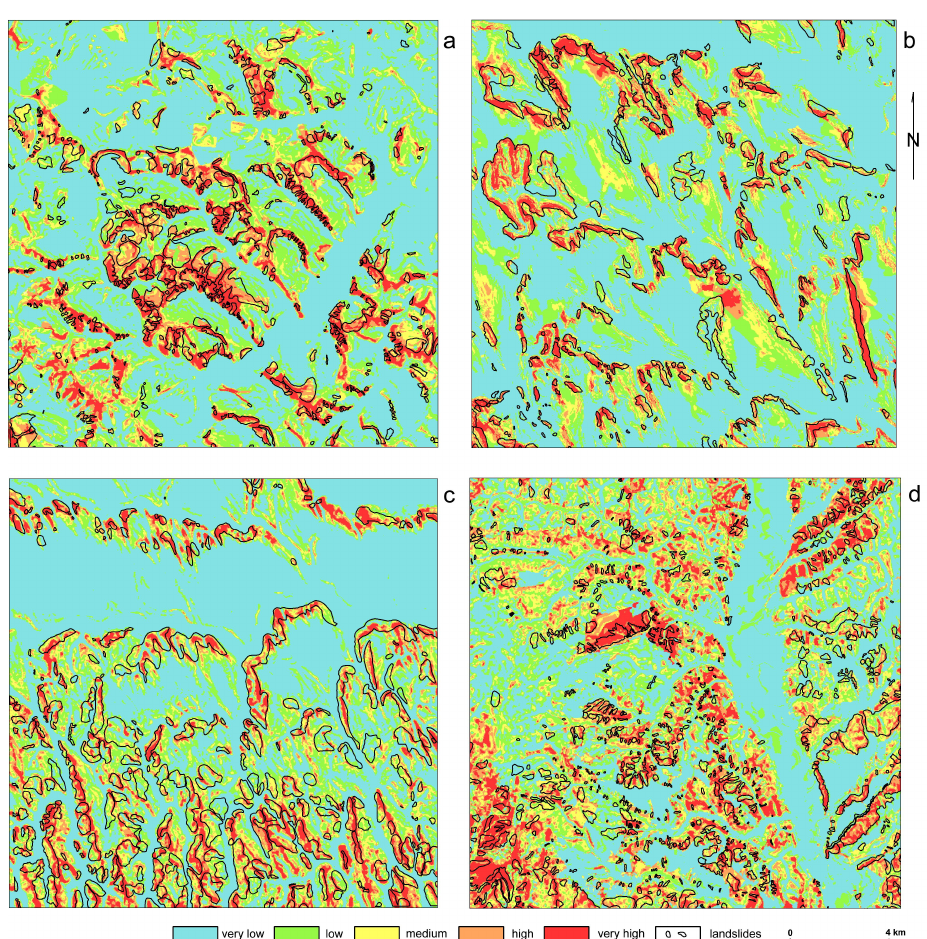
Fig. 9. Classified landslide susceptibility maps: (a) C˘apu¸su de Câmpie sector; (b) ¸Sipote sector; (c) Lungani sector; (d) Helegiu sector.